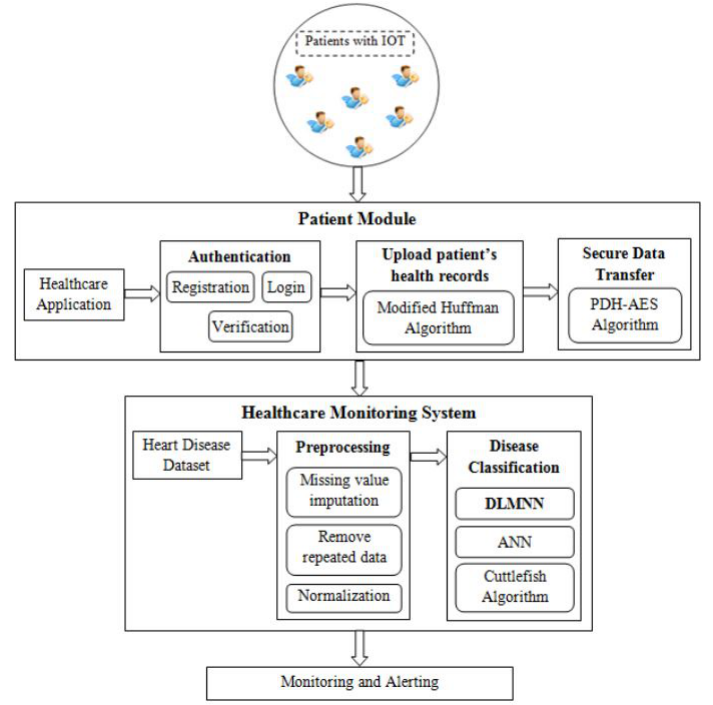
Figure 22. The presented classification DNN with the use of the OCS algorithm in